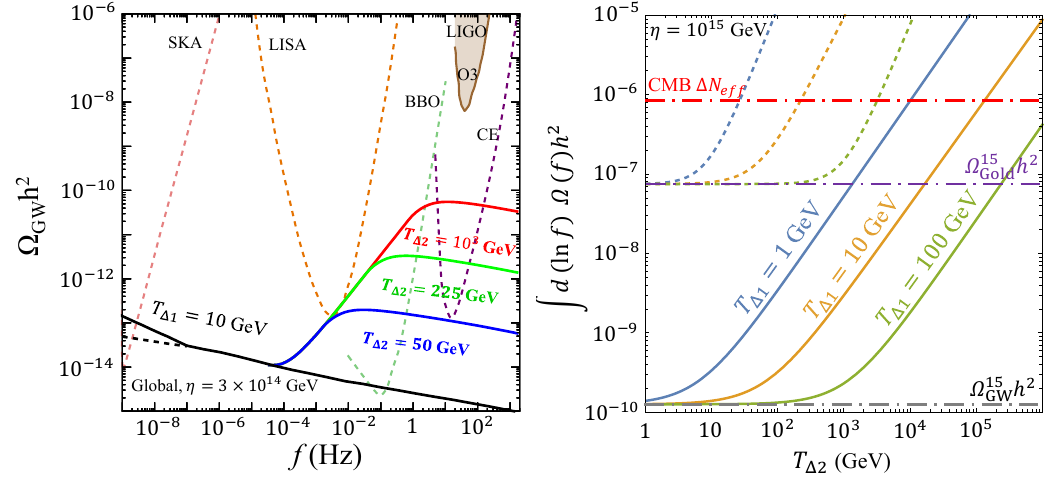
Figure 10 . Left panel: examples of GW spectra from global strings with two-stage phase transitions including kination: from an early RD era to kination at T standard cosmology at T . Right panel: the relic energy densities of GWs (solid) and Goldstones ∆1 (dashed) from global strings with varying phase transition temperatures ( T dotted-dashed line shows the CMB bound on extra radiation energy density [130,